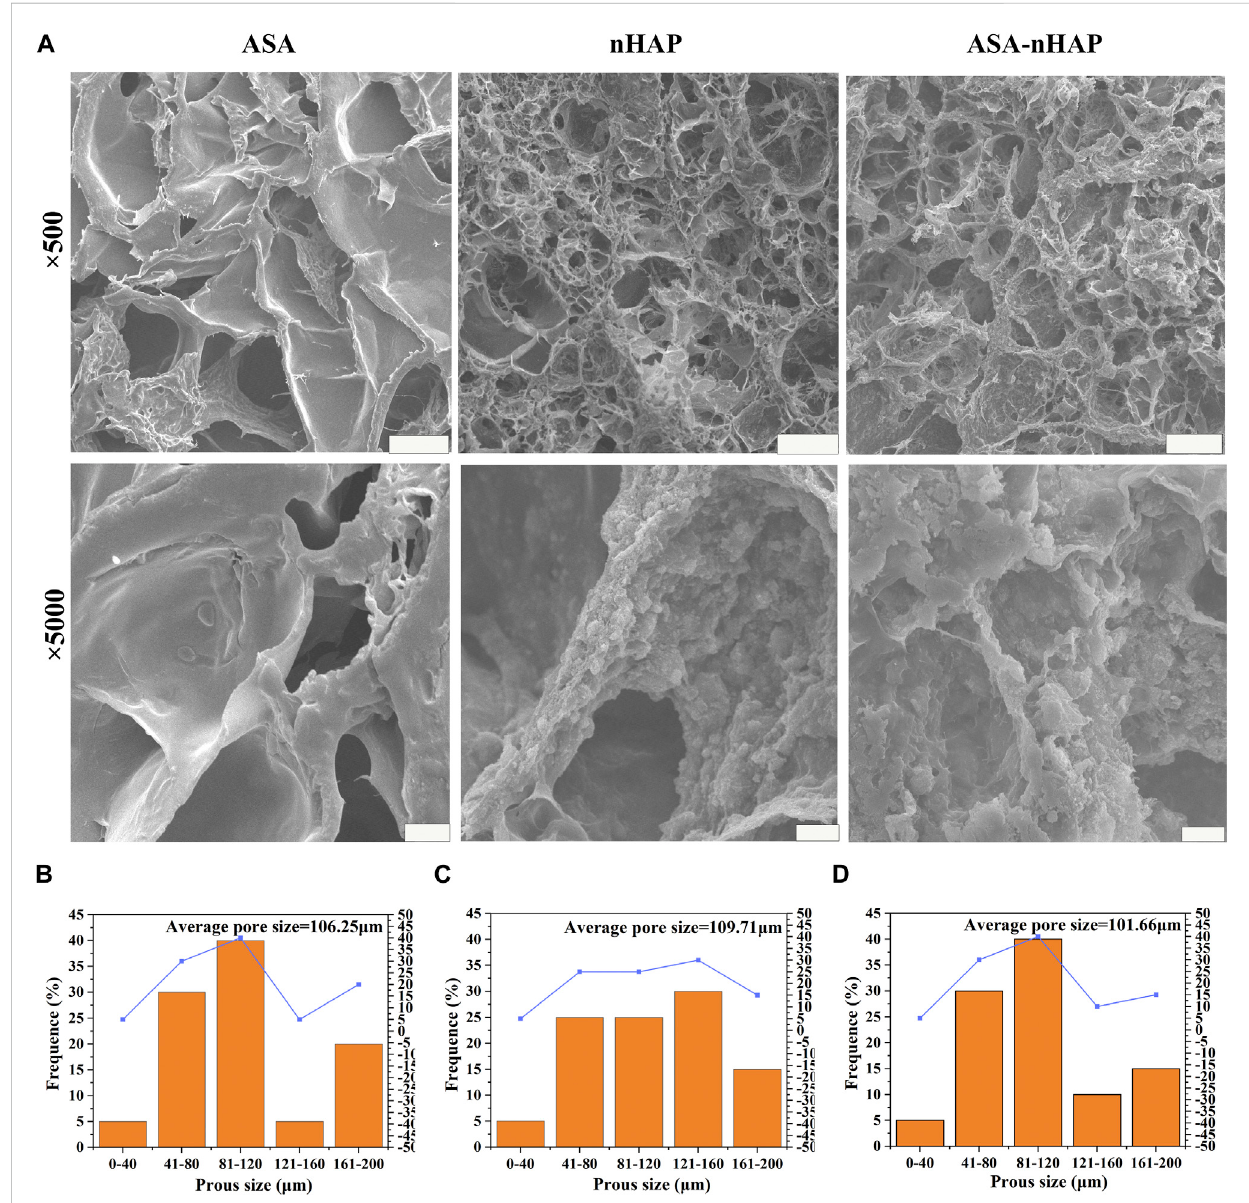
FIGURE 2 Microstructure of hydrogel scaffolds. (A) SEM images of the ASA group, nHAP group, and ASA-nHAP group. The scale bar for low-magni fi cation images is 100 μ m; the scale bar for high-magni fi cation images is 10 μ m. (B – D) Pore size distribution pattern of the ASA group, nHAP group, and ASA- nHAP